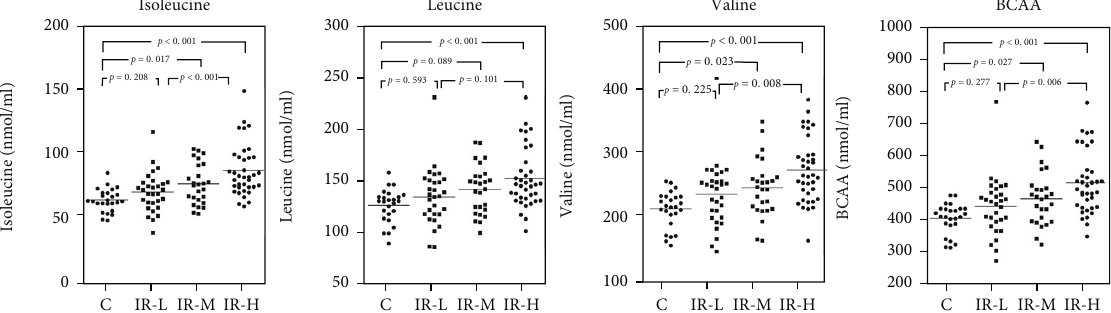
Figure 3: Intergroup comparisons for BCAAs in the control and T2DM groups. Statistical analysis was performed using the Steel – Dwass method. The horizontal solid lines indicate the mean values for each group. IR-L, T2DM with HOMA − IR ≤ 1 : 60 ; IR-M, T2DM with 1 : 6 < HOMA − IR < 2 : 5 ; IR-H, T2DM with HOMA − IR ≥ 2 : 5 . BCAAs: branched-chain amino acids; T2DM: type 2 diabetes mellitus; HOMA-IR: homeostasis model assessment of insulin